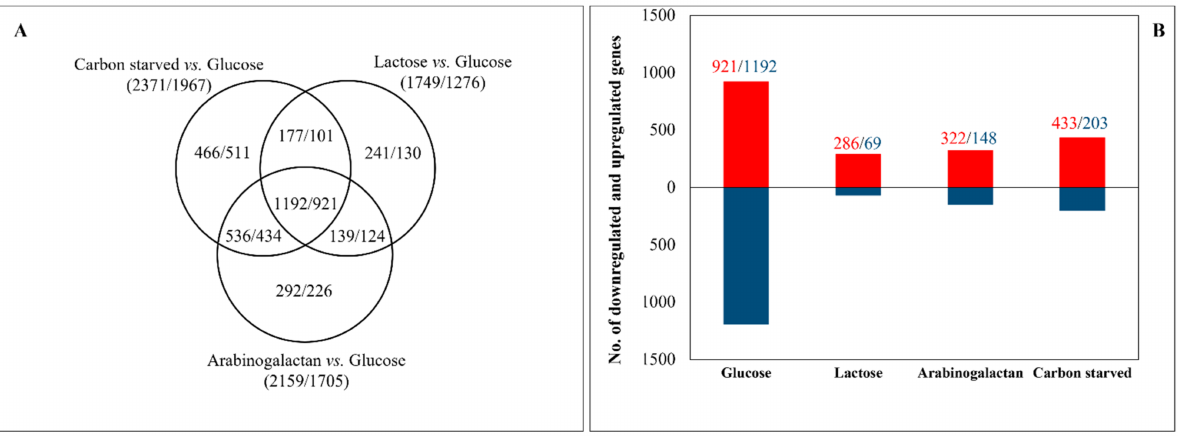
Figure 2. Distribution of carbon-stress-responsive ( A ) and culture-specific ( B ) genes among the cultures. Figures represent the number of upregulated/downregulated genes. Note, the three sets in ( A ) contain carbon-stress-responsive genes, and the intersection of the three sets contains the general stress response genes (using glucose-containing cultures as reference). The upregulated general stress response genes are identical with the downregulated glucose-specific genes and the downregulated general stress response genes are identical with the upregulated glucose-specific genes ( B